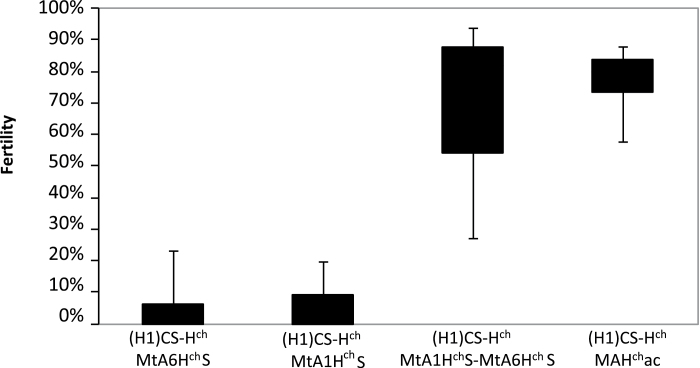
Male fertility restoration of the alloplasmic line Chinese Spring in H. chilense cytoplasm, with different chromosome additions: 6HchS, 1HchS, 6HchS+1HchS, and Hchac. (H1)CS-Hch MtA6HchS, CS-H. chilense monotelosomic addition of 6HchS; (H1)CS-Hch MtA1HchS, CS-H. chilense monotelosomic addition of 1HchS; (H1)CS-Hch MtA1HchS-MtA6HchS, CS-H. chilense monotelosomic addition of 1HchS-monotelosomic addition of 6HchS; (H1)CS-Hch MAHchac, CS-H. chilense monosomic addition of Hchac in H1 cytoplasm.